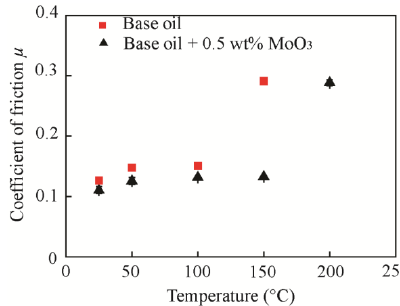
Figure 12. Average friction coefficient of the base oil and with 0.5 wt % micro-lamellar MoO 3 additives under different temperatures.